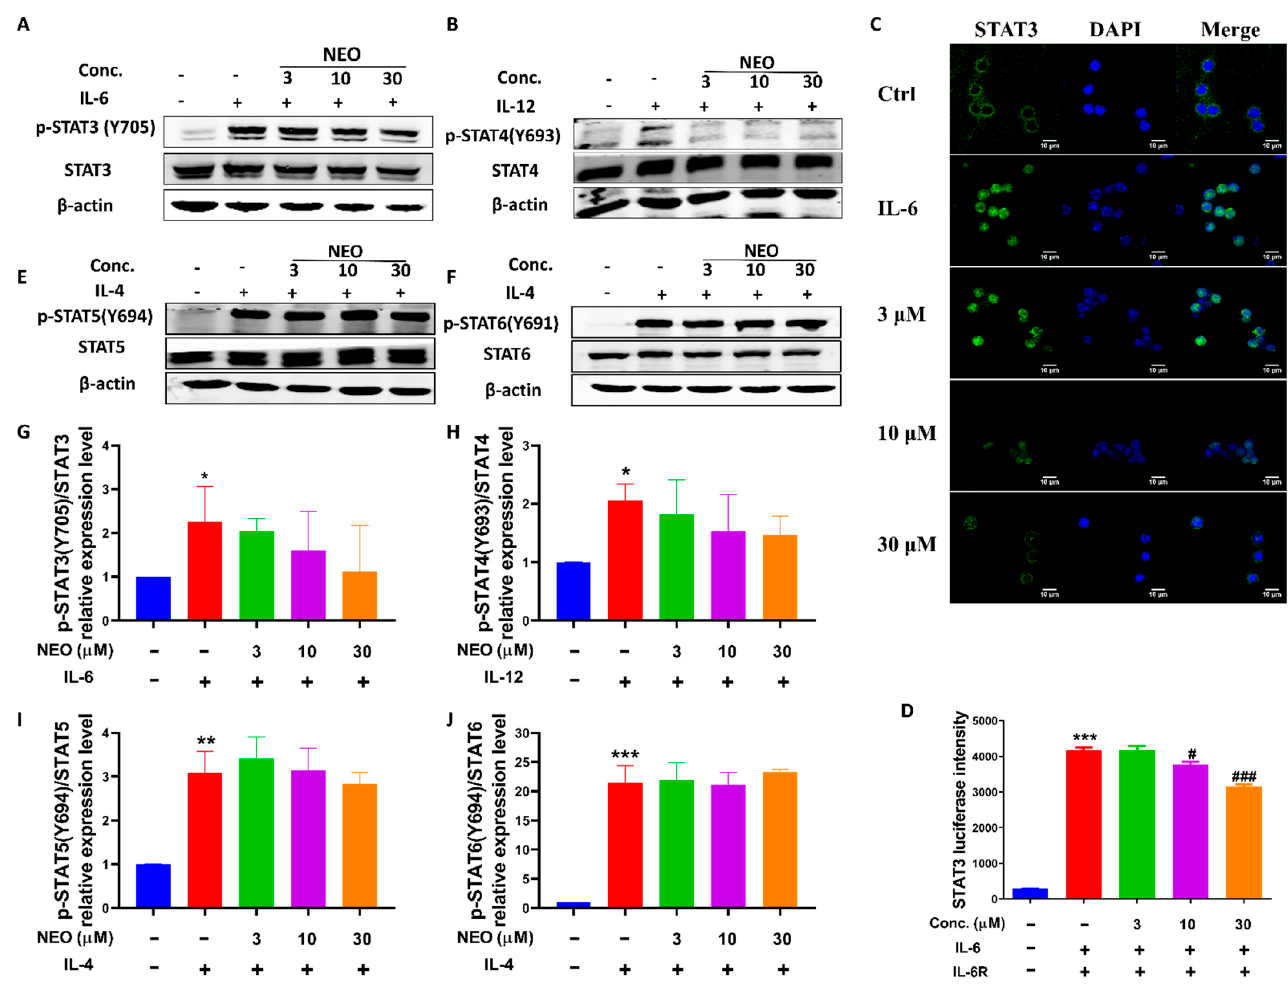
Figure 8. Blockage in STAT3 signaling by NEO. Effects of NEO on the levels of p-STAT3(Tyr725) ( A , G ), p-STAT4 (Y693) ( B , H ), p-STAT5 (Y694) ( E , I ), p-STAT6 (Y641) ( F , J ) in splenocytes stimulated with the indicated cytokines. The results represent three independent experiments. ( C ) NEO restricted nucleus location of STAT3. ( D ) NEO down-regulated STAT3 transcriptional activity. * p < 0.05, ** p < 0.01 and *** p < 0.001 indicated that the differences were statistically significant vs. control group; whereas, # p < 0.05, and ### p < 0.001 declared statistically significant differences vs. IL-6, IL-12 or IL-4 group (n =